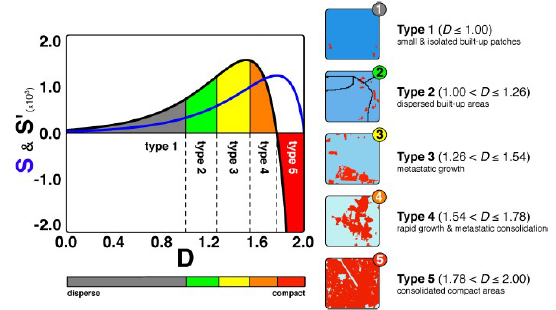
Figure 2. Types of built-up areas. Source: (Encarnação et al., 2012)